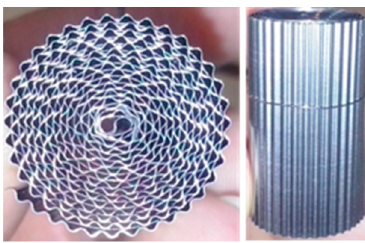
Figure 10. Manufactured metallic micromonolith.